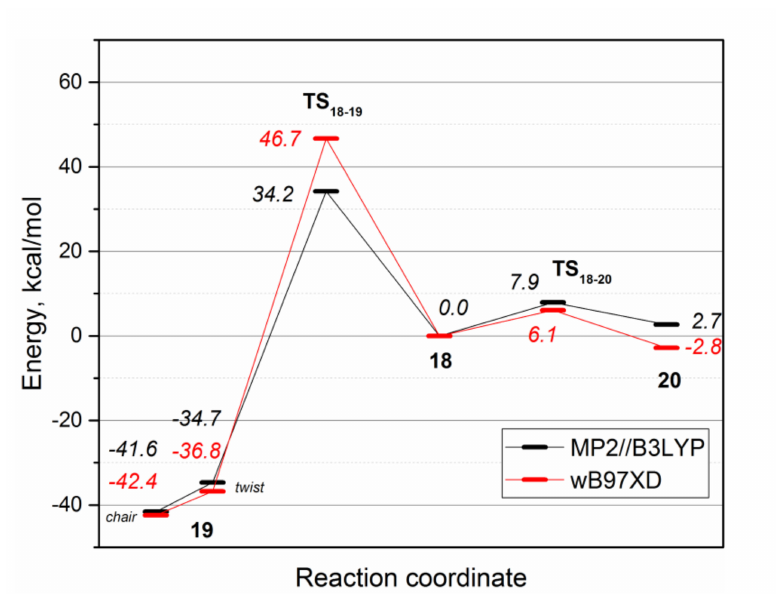
Figure 3. Energy diagram for conversion of adduct 18 to 1,4-azasilinane 19 and aziridine 20 . R = R 1 = CH 3 (refer to Scheme 10 for